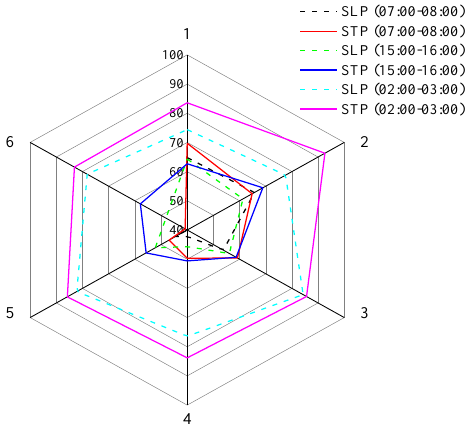
Figure 8. Comparison of routes searched by Actual Path, Shortest Length Path and Shortest Time Path STP.